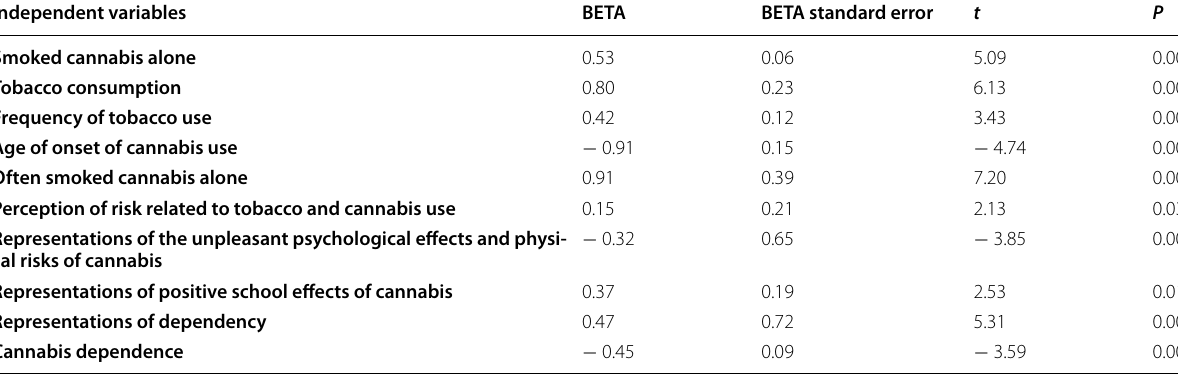
0.82; F 7.03; p 0.000) = = =